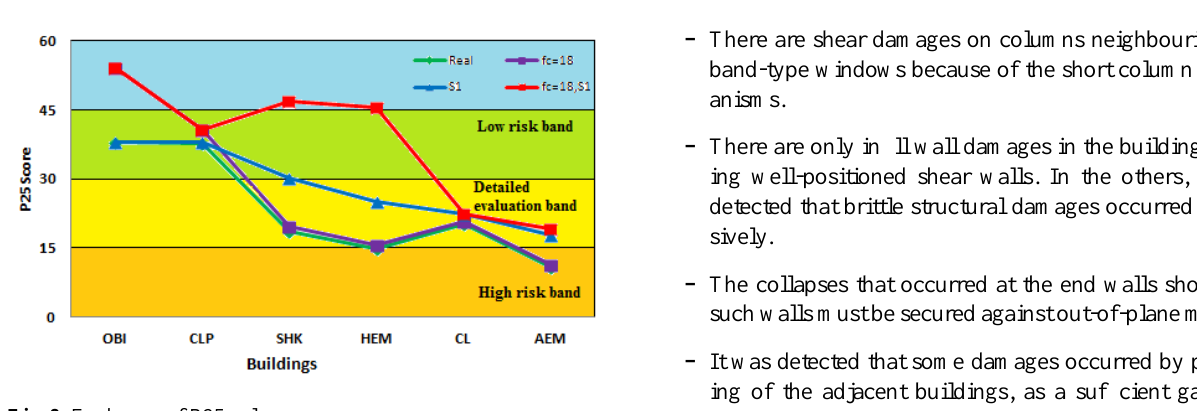
Fig. 8. Exchange of P25 values. 4 other parameters were kept constant at their values. In the last step, by using the selected concrete strength and soil type, P25 scores were re-calculated. The variations of the calcu- lated P25 scores are given in Fig.